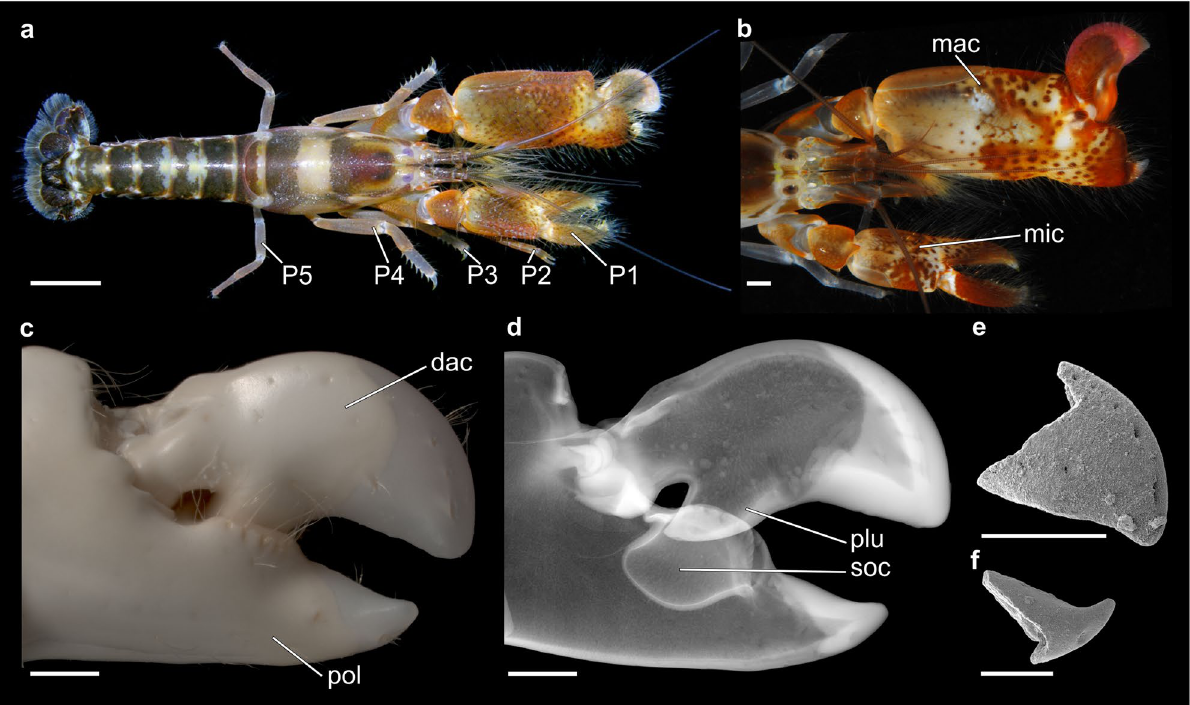
Figure 1. Morphology of alpheids and their snapping claw in comparison to selected fossil specimens. ( a ) Dorsal view of Alpheus rugimanus , in life. ( b ) Dorsal view of the assymetrical chelipeds of Alpheus websteri , in life. ( c ) Major cheliped of Alpheus bisincisus , preserved specimen (NHMW-CR-25767). ( d ) µ CT-based X-ray image of the snapping claw shown in ( c ). ( e ) SEM micrograph of an allegedly cephalopod fossil specimen, the holotype of Oligosella longi (NCSM 10984). ( f ) SEM micrograph of another allegedly cephalopod fossil specimen, the holotype of Oligorostra alabami (NCSM 10980). Scale bars equal 5 mm ( a ) and 1 mm ( b – f ). dac = dactylus, mac = major cheliped, mic = minor cheliped, P1–P5 = pereiopods 1–5, plu = plunger, pol = pollex, soc =